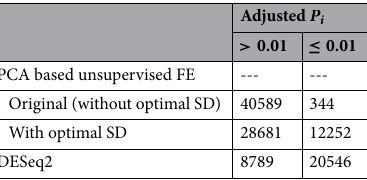
Table 3. The number of genes selected with original PCA-based unsupervised FE, that with optical SD, and DESeq2.